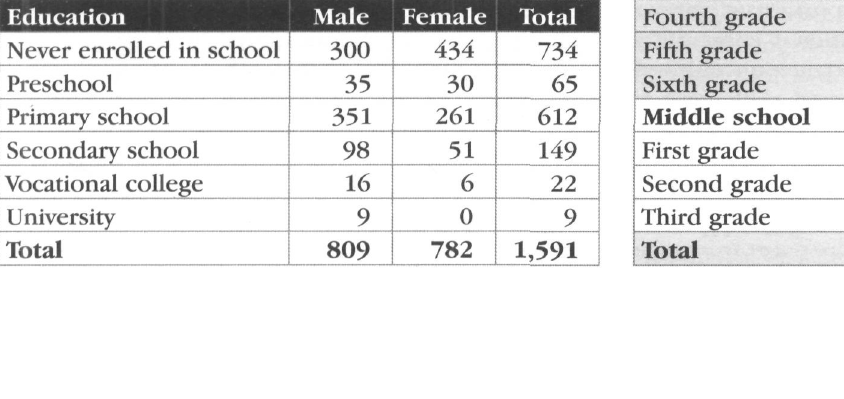
Table 4. Level of formal education in Maesa Mai village (Leepreecha, 2001, p.